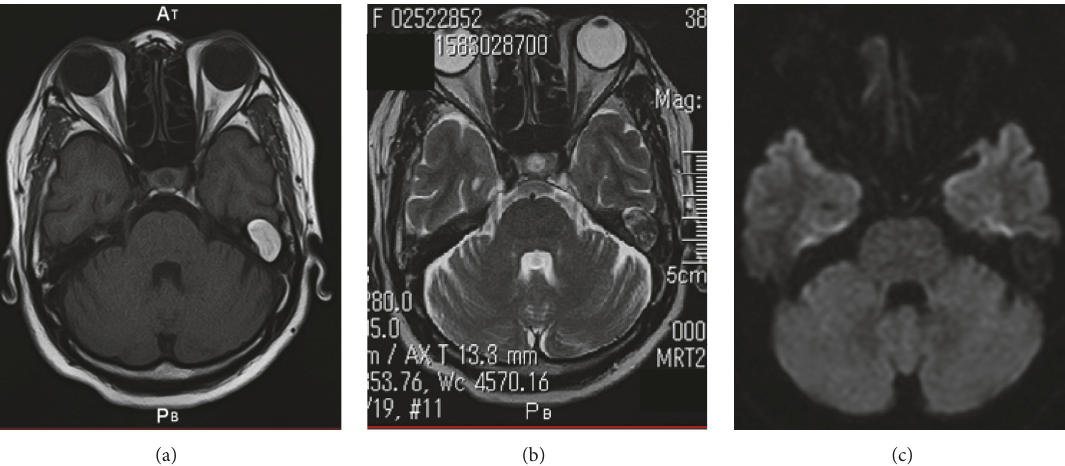
Figure 3: (a) Axial T1-weighted temporal bone MRI showing a signal-hyperintense mass neighboring the posterior cranial fossa and extending to the middle fossa. (b) Axial T2-weighted imaging of the temporal bone shows a high-intensity periphery and low-intensity central mass. (c) DWI shows an isointense signal rather than high intensity.